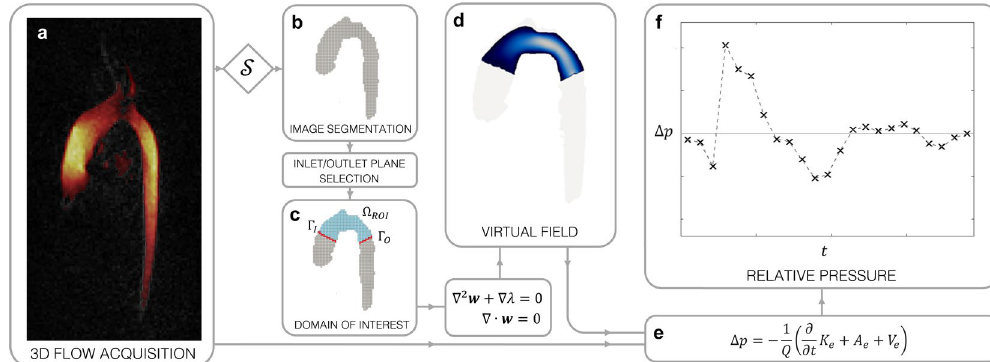
Figure 1. Overview of ν WERP estimation from 4D flow data. (a) Acquisition of 4D flow with velocity magnitude ( > 1/4 th maximum velocity) highlighted by the red-to-yellow color scale. (b) Segmentation of the primary flow domain. (c) Manual selection of inlet and outlet planes, Γ I and Γ O , for the relative pressure estimation. (d) Using segmentation, the domain of interest, Ω ROI , and inlet/outlet planes, a separate Stokes flow boundary value problem is solved to create the virtual field w . (e) The virtual work-energy of the field w is combined with the acquired velocity field v to compute the relative pressure. (f) Final relative pressure between inlet and outlet planes over